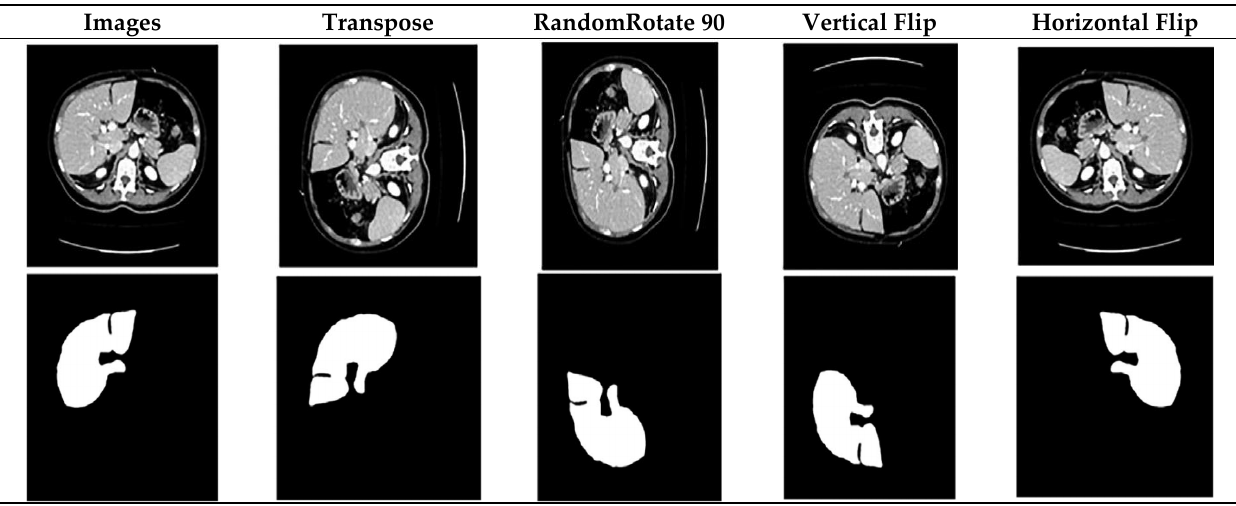
Table 1. Detailed info of 3Dircadb. (F: Female; M: Male).